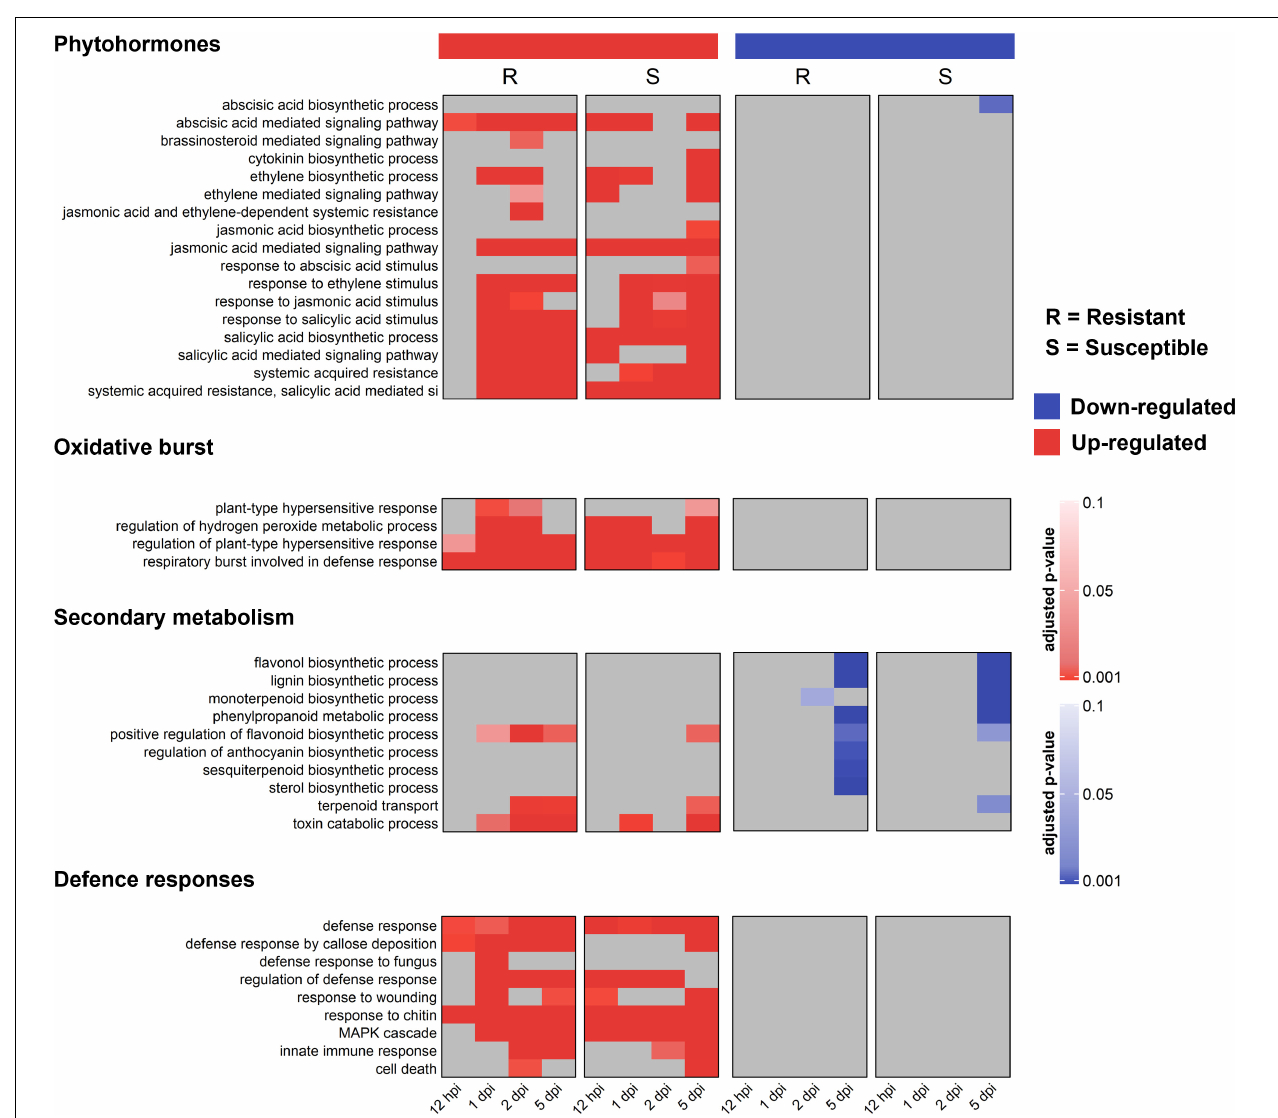
FIGURE 3 | Gene ontology (GO) biological processes (BP) functional characterization of significantly differentially expressed genes (DEGs) in the R- and S-interactions, showing selected defense-related terms over time. Red bars represent up-regulated, and blue bars represent down-regulated GO terms. Color bars indicate significance with an adjusted p -value ≤